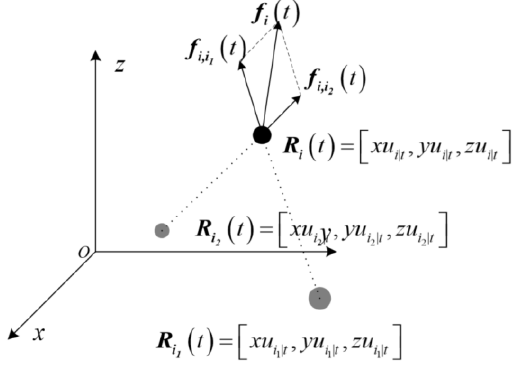
Figure 2. Virtual force model.